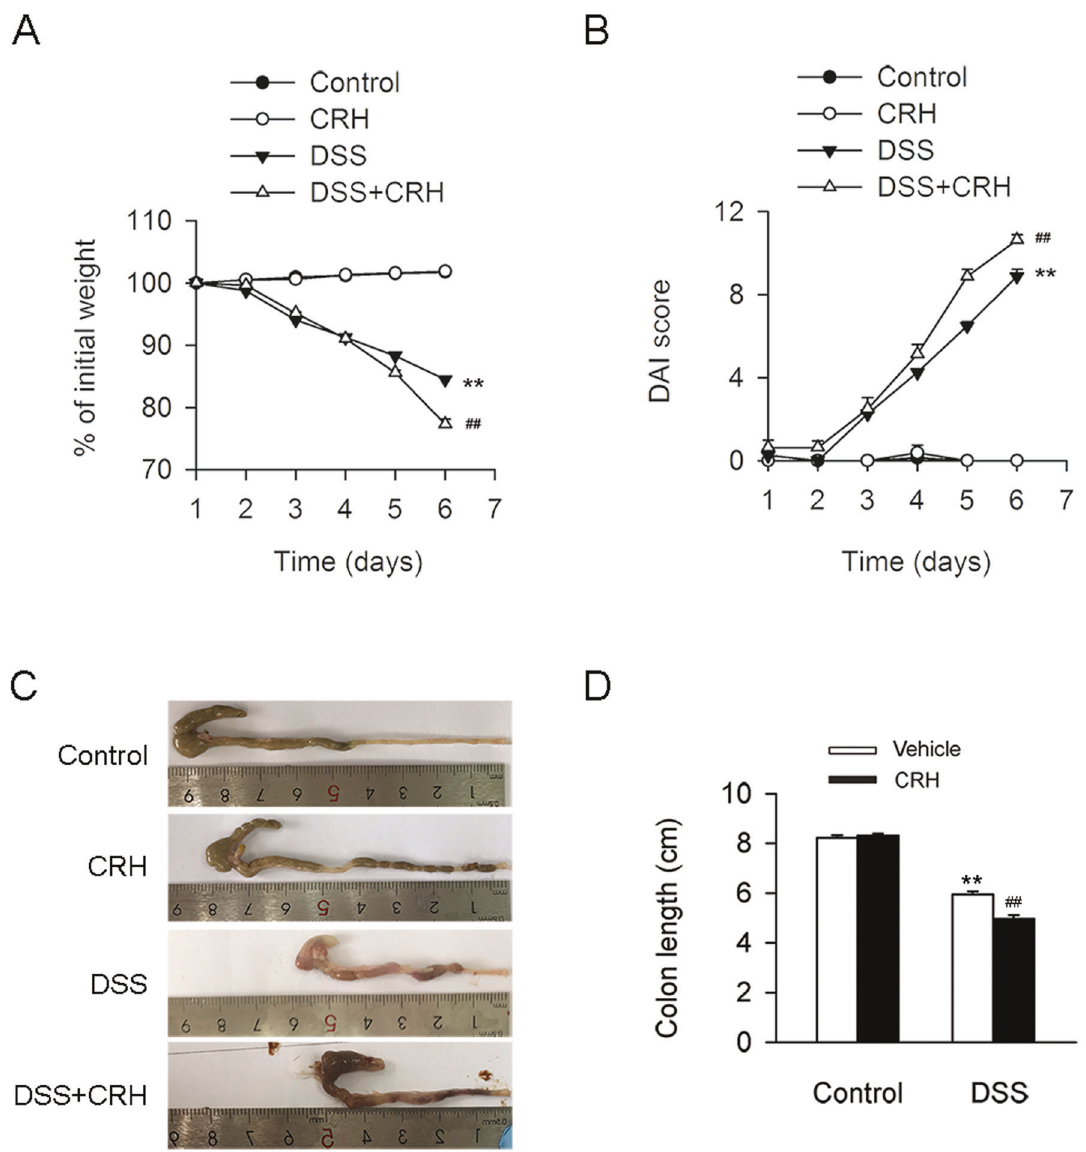
Fig. 1 Peripheral administration of CRH contributed to the deterioration of IBD. C57BL/6 mice were administered DSS (3%) for 6 days (and a control group was provided with water only for comparison). For the CRH treatment group, CRH (or vehicle only) was intraperitoneally injected at a dose of 50 μ g/kg body weight from day 1 to day 6 using saline as the vehicle. Body weight loss, stool consistency, occult or gross blood per rectum, and colon length were then recorded by two researchers who were blinded to the treatments. A – D In comparison with the DSS + vehicle group, mice in the DSS + CRH group demonstrated a signi fi cant aggravation of IBD-associated changes in body weight, DAI score, and colon length ( n = 8 per group). ** P < 0.01 vs. the control group; ## P < 0.01 vs. the DSS + vehicle the intestinal mucosal barrier, shown by the number of E- cadherin-positive fl uorescence points, was signi fi cantly decreased in the colonic organoids cocultured with LPS-activated macro- phages (Supplementary Fig. 3B). Induction of autophagy by rapamycin aggravated CRH- induced colonic damage in an IBD mouse model The effects of autophagy on CRH-induced intestinal damage were also examined following rapamycin induction of autophagy (Supplementary Fig. 4). IBD-associated body weight loss, DAI score, change in colon length, and in fl ammatory in fi ltration in the left colon were all signi fi cantly aggravated in the DSS + rapamycin